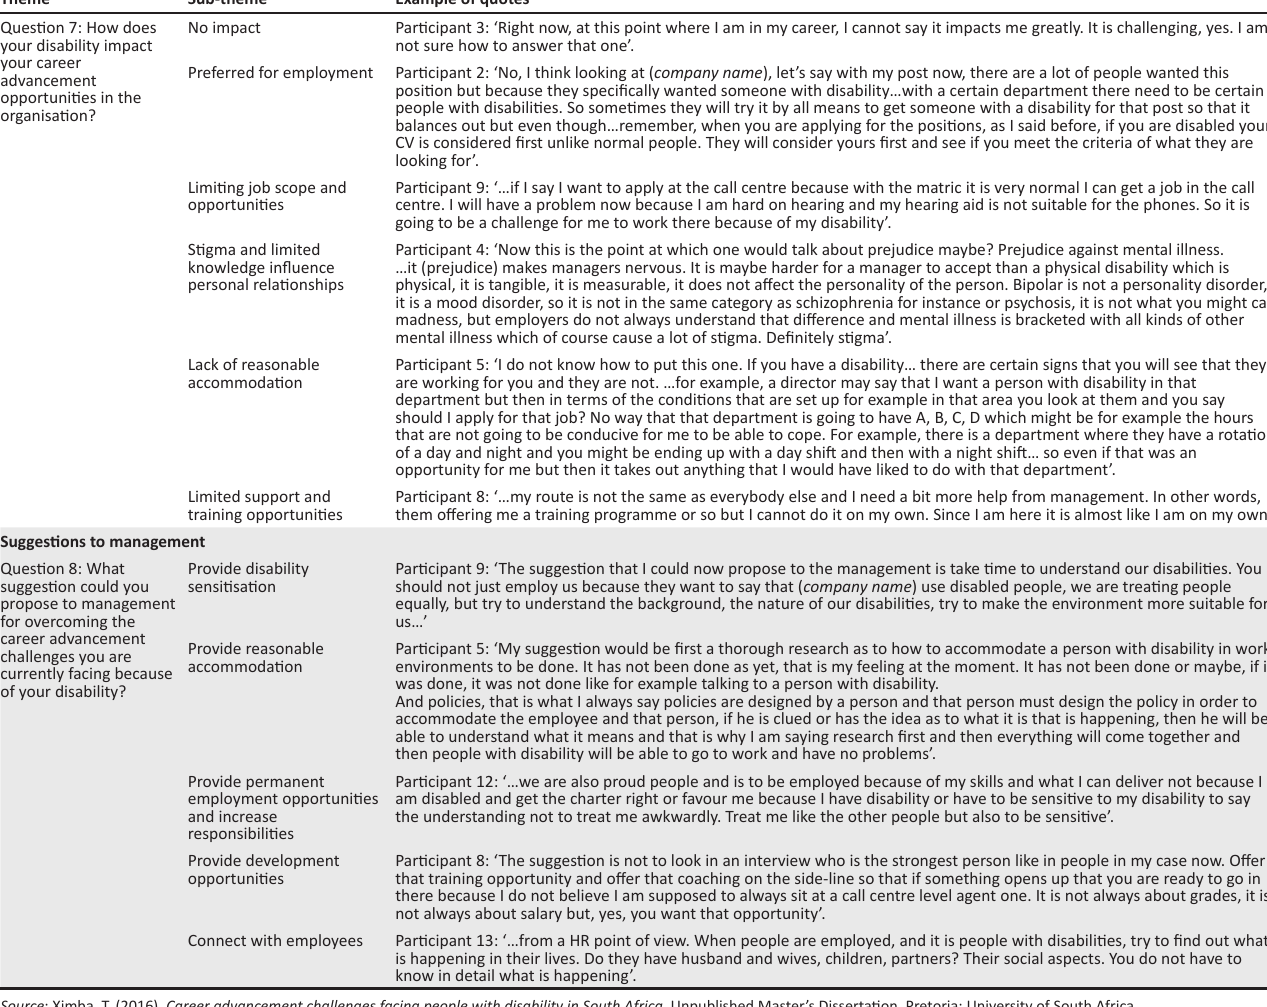
TABLE 1 (Continues...): Summary of the core themes pertaining to career advancement issues faced by people with